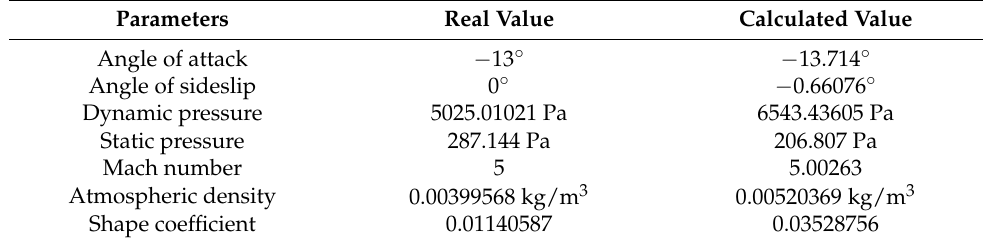
Figure 10. Pressure distribution diagram. Table 1. Calculated parameters and real parameters of specific